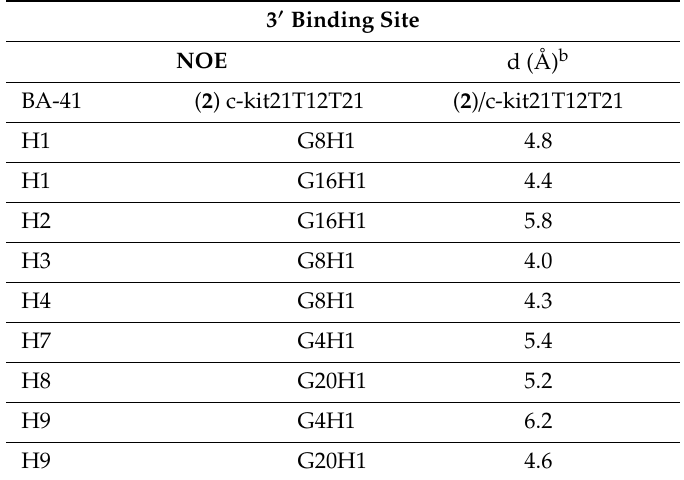
Table 2. Intermolecular NOE in the complexes of 2 with c-kit21T12T21. a